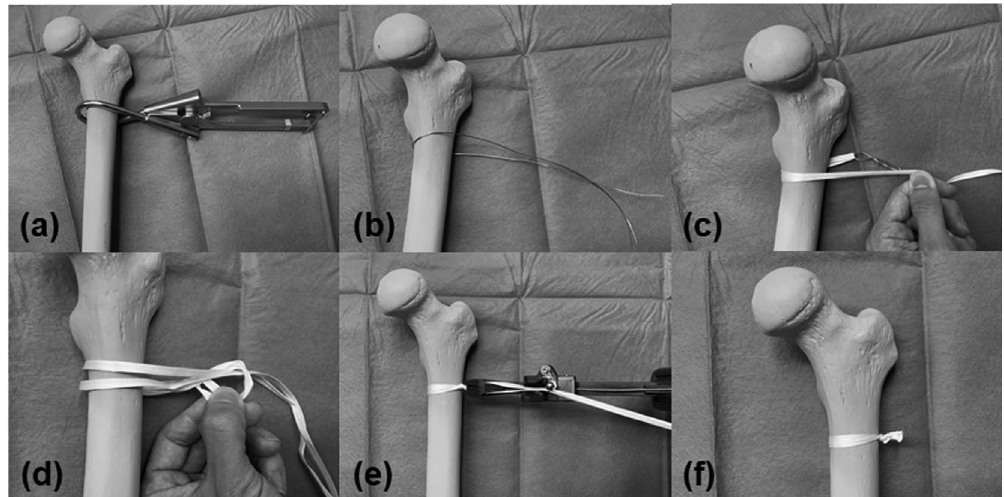
Figure 3. These pictures are the summaries of our surgical technique. (a, b) Cerclage soft steel wire over the lesser trochanter. We recommend using a cerclage passer (cid:3) for easy cerclage. (c) The Nesplon tape (cid:3) was passed using soft steel wire. (d, e, f) Strong knots were made using a tightening gun, and the tape was cut at the distal